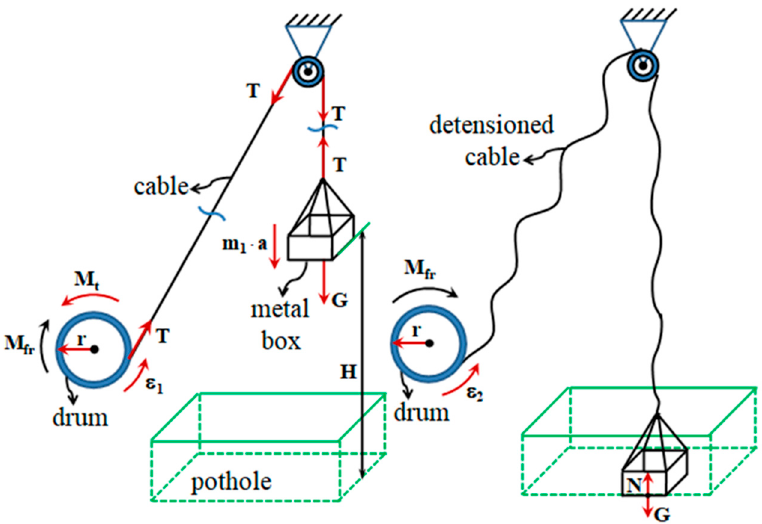
Figure 18. Computer-assisted gravitational method, representation of forces and moments.